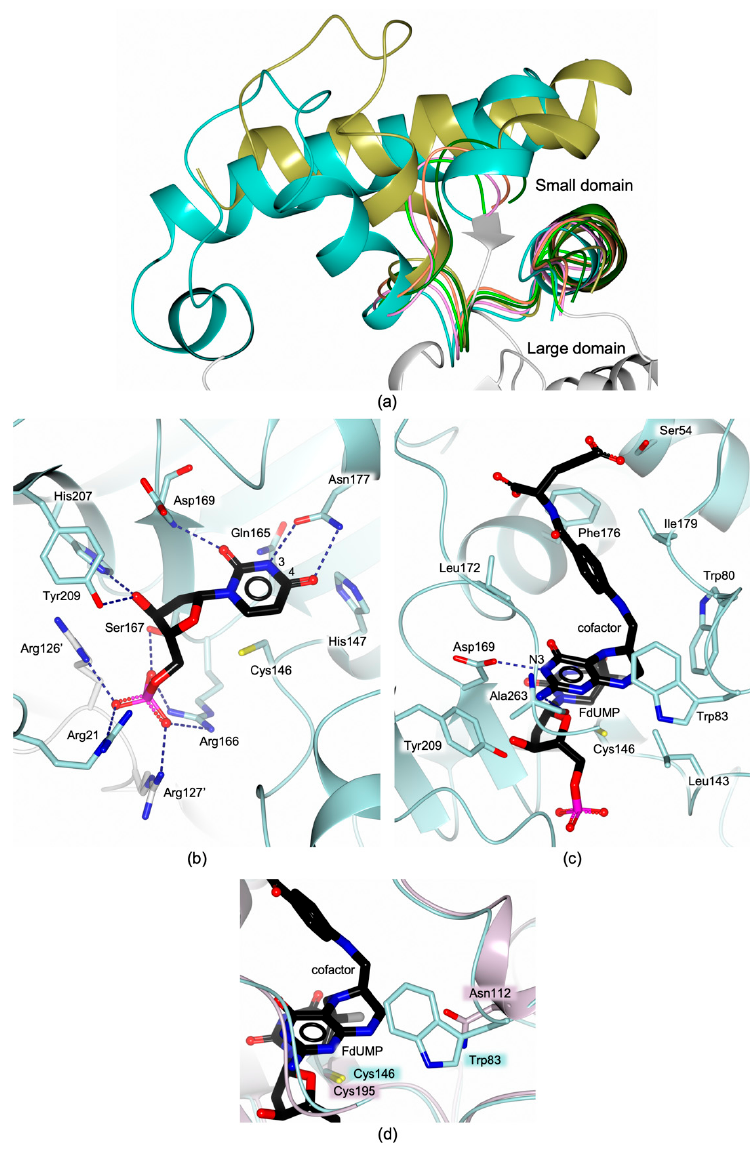
Figure 3. ( a ) Superimposition among the SD of Mtb TS (PDB id 3QJ7, unpublished research,